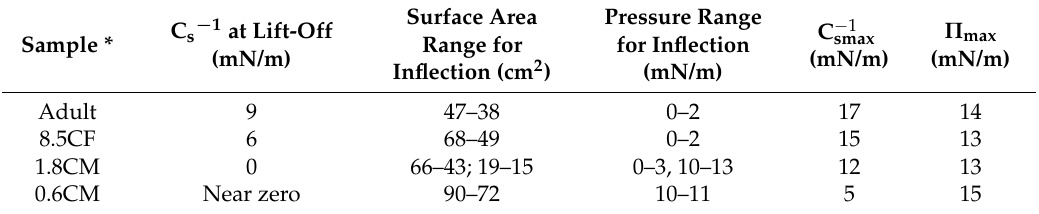
Table 2. Reciprocal compressibility moduli and inflections for meibum films with maximal reciprocal